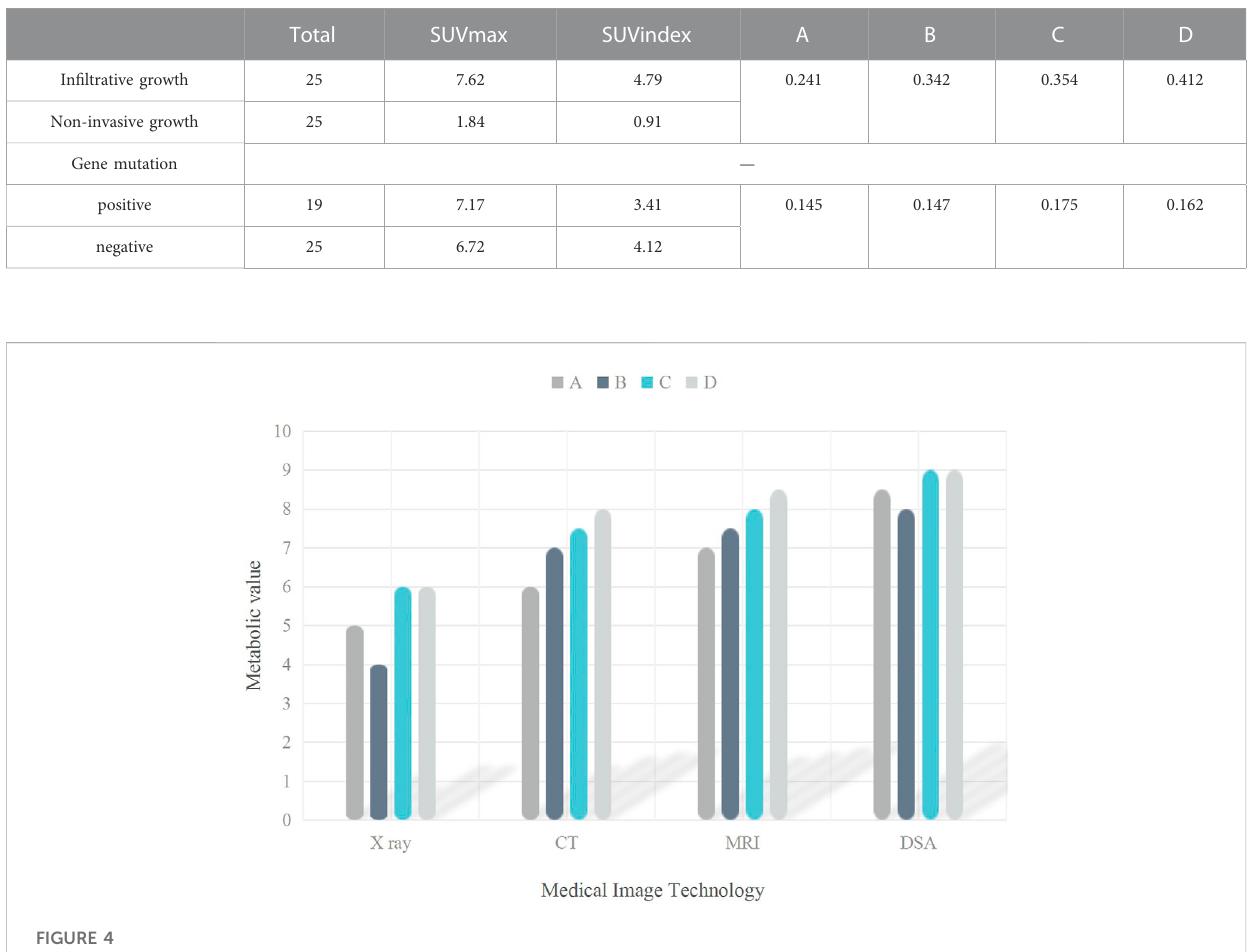
TABLE 3 Relationship between driver gene abnormalities and tissue type.